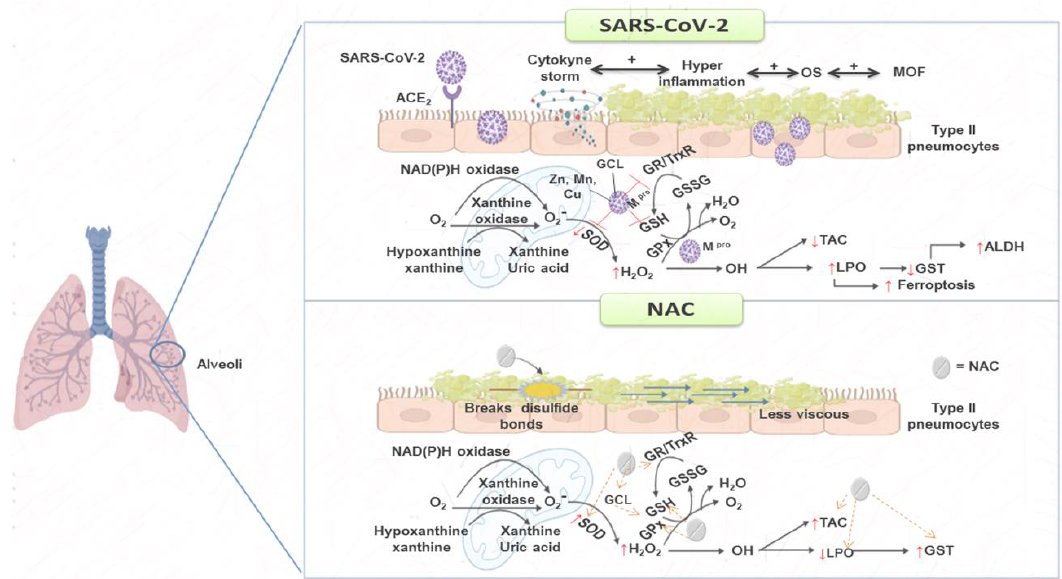
Figure 3. The treatment with NAC as an adjuvant therapy may contribute to reducing the OS associated with SARS-CoV-2 infection through GSH generation, which favors the increase in the enzymes that employed this antioxidant molecule. Abbreviations: Cu= copper, GCL= glutamate cysteine ligase, GPx= glutathione peroxidase, GR= glutathione reductase, GSH= glutathione, GSSG= oxidized glutathione, GST= glutathione-S-transferase, H 2 O 2 = hydrogen peroxide, LPO= lipoperoxidation, Mn= manganese, MOF = multiple organ failure, NAC= N-acetylcysteine, O 2– = superoxide anion, OH= hydroxyl, OS= oxidative stress, SOD= superoxide dismutase, TAC= total antioxidant capacity, TrxR= thioredoxin reductase, Zn= zinc.